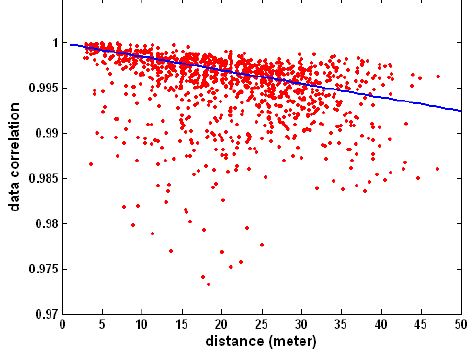
Figure 2. Data correlation vs. distance.